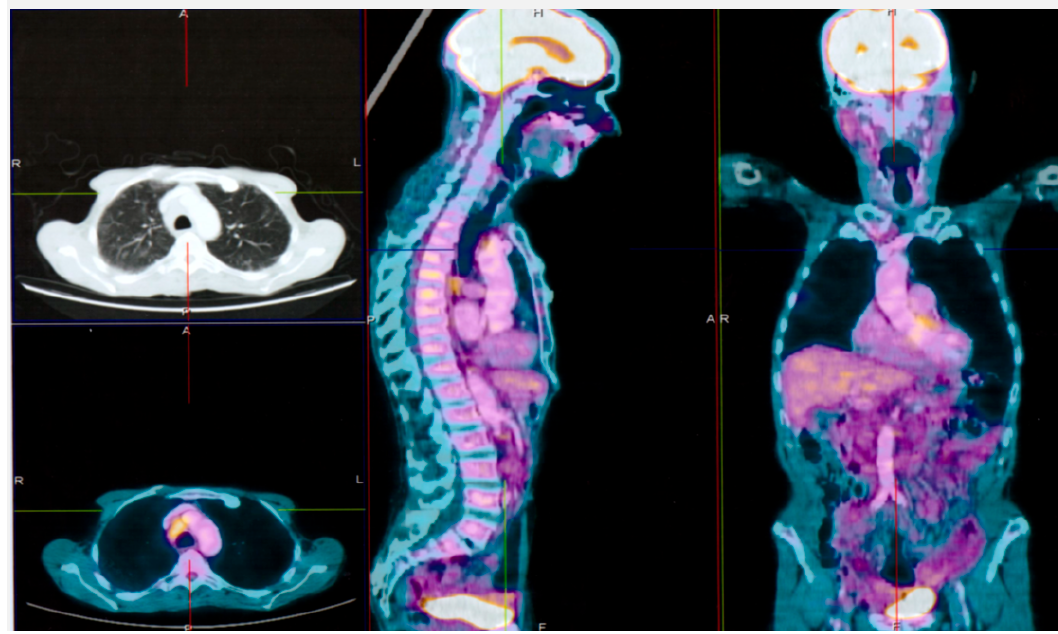
Figure 2. [18F] FDG-PET performed with co-registered CT in follow up (October 2019) not show significant areas of increased metabolic activity in abdominal cavity.